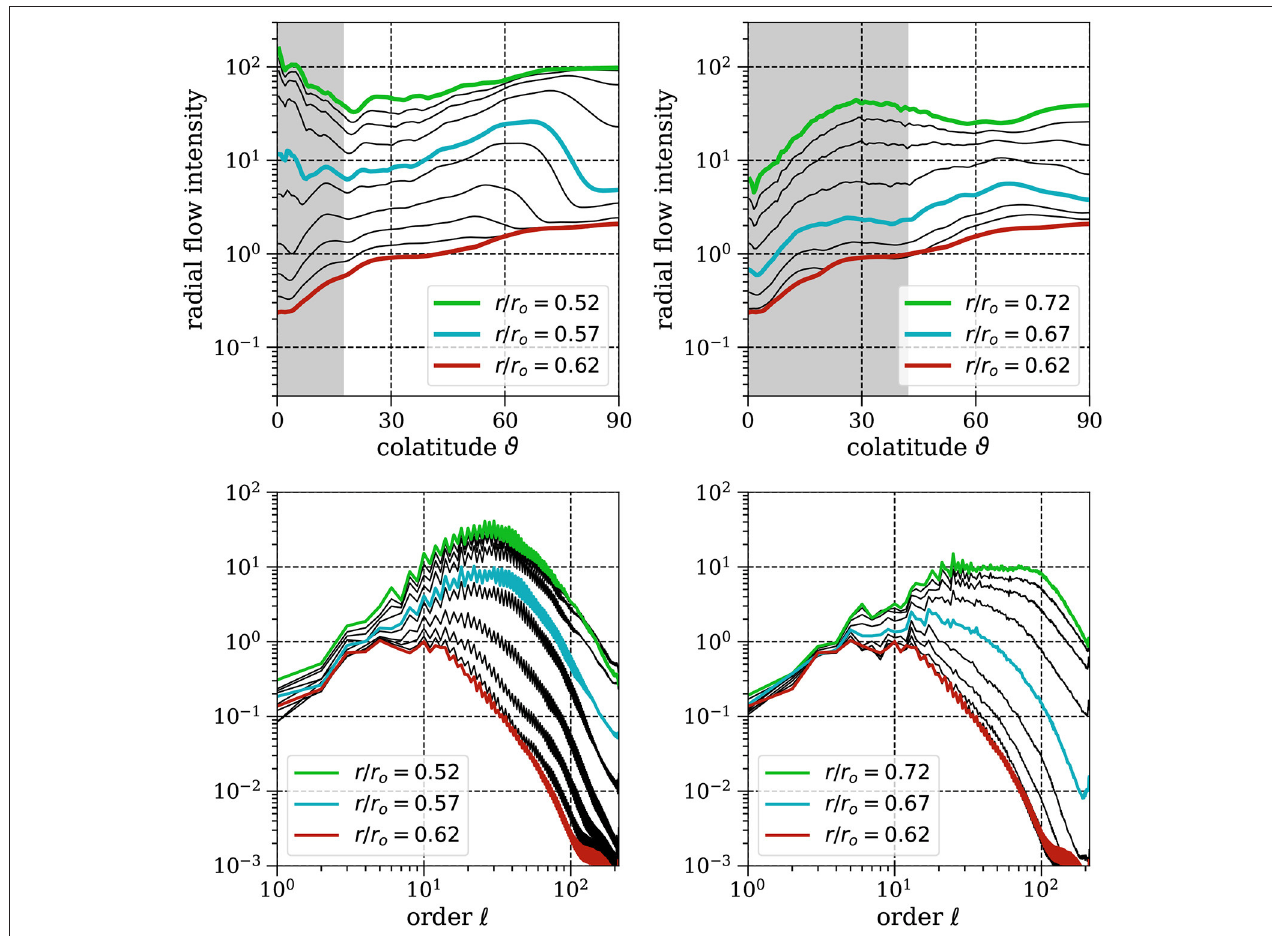
FIGURE 6 | Time and azimuthally averaged intensity of radial flows at various depth around the edge of the SSL r lb plot show profiles along colatitude, the lower for spectral degree (length scale). The gray shaded areas mark colatitude bands inside the tangent cylinder set in the r i / r lb (top left) and in the outer convective shell by sin ϑ TC inner convective shell by sin ϑ TC =